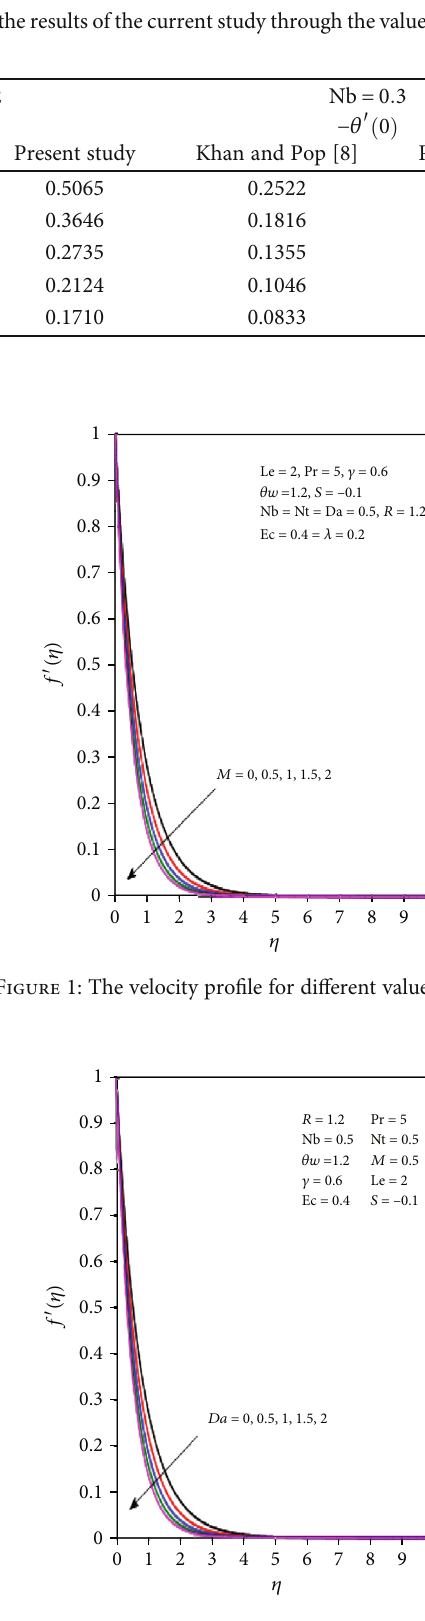
Figure 2: The velocity pro fi le for di ff erent values of Da